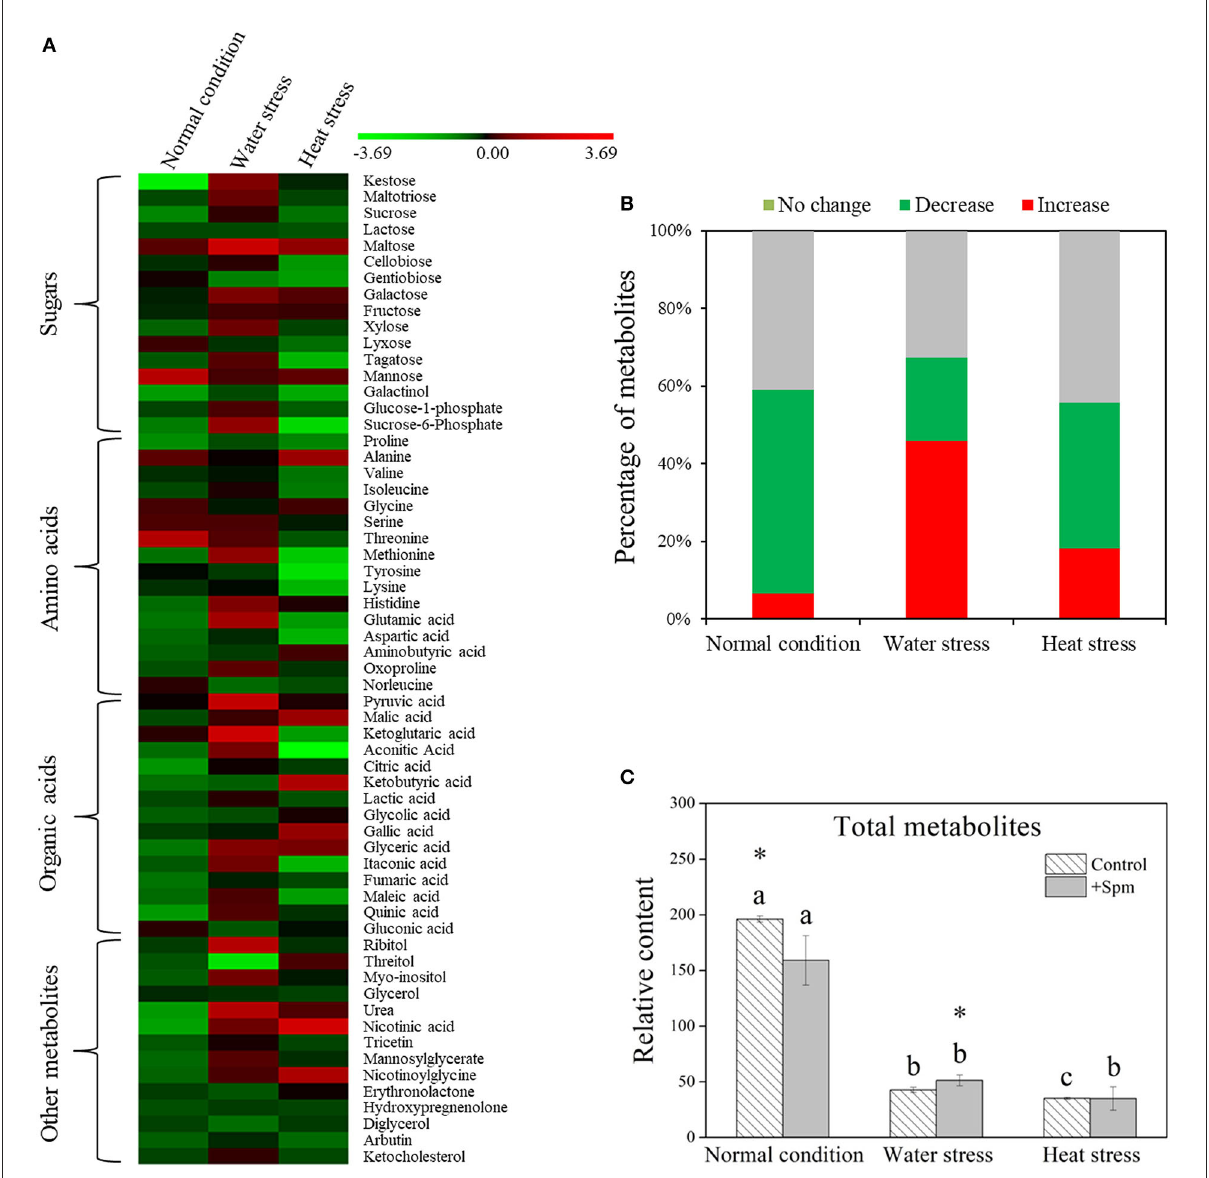
FIGURE5 Changes in (A) the heatmap of all identified metabolites, (B) percentage of upregulated, downregulated, and unchanged metabolites, and (C) relative content of total metabolites in response to Spm application under different conditions. Vertical bars indicate ± SE of mean ( n = 4). Different letters above striated or gray columns indicate significant differences for a particular treatment (Control or + Spm) for comparison across the normal condition, water stress, and heat stress; the asterisk “*” indicates significant differences between the control and the + Spm treatments under one particular condition (normal condition, water stress, or heat stress) based on LSD ( P <